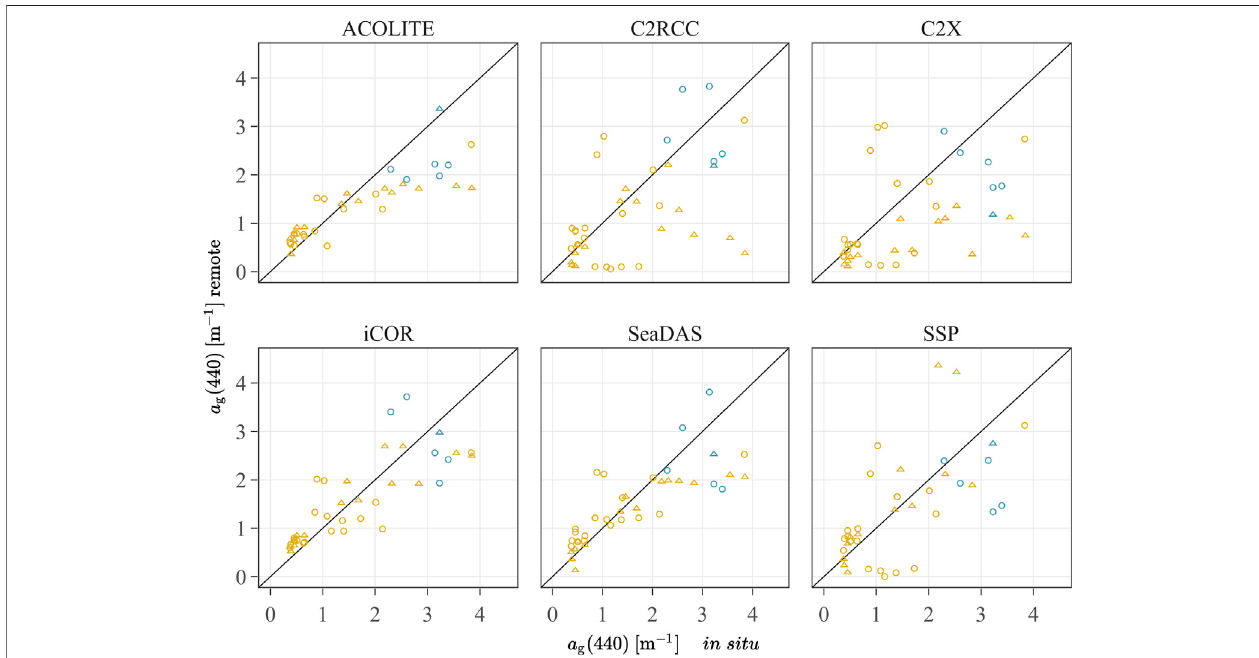
FIGURE 10 | a g (440) measured in situ vs. estimated remotely with the R rs (665)/ R rs (560) empirical algorithm applied to MSI (circle) and OLI (triangle) in the EGSL (orange) and JB (blue). The solid black line represents the 1:1 relation.